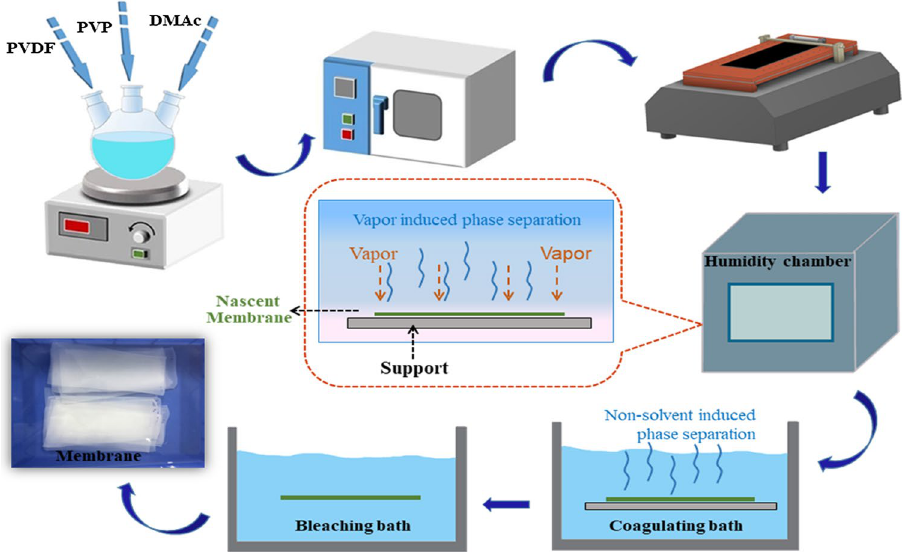
Fig. 1 The flowchart of the PVDF membrane preparation